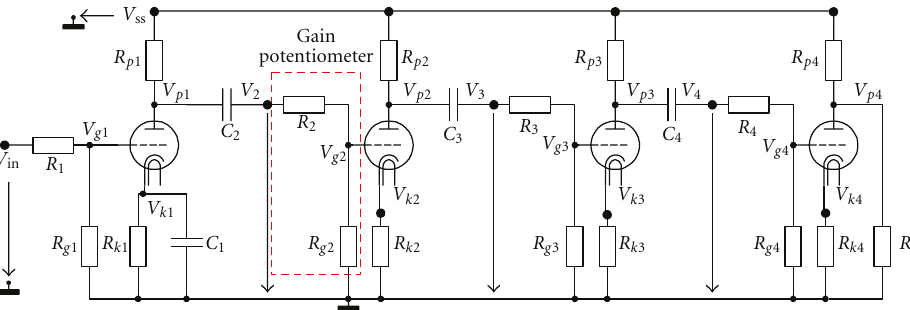
Figure 1: A guitar tube preamp circuit